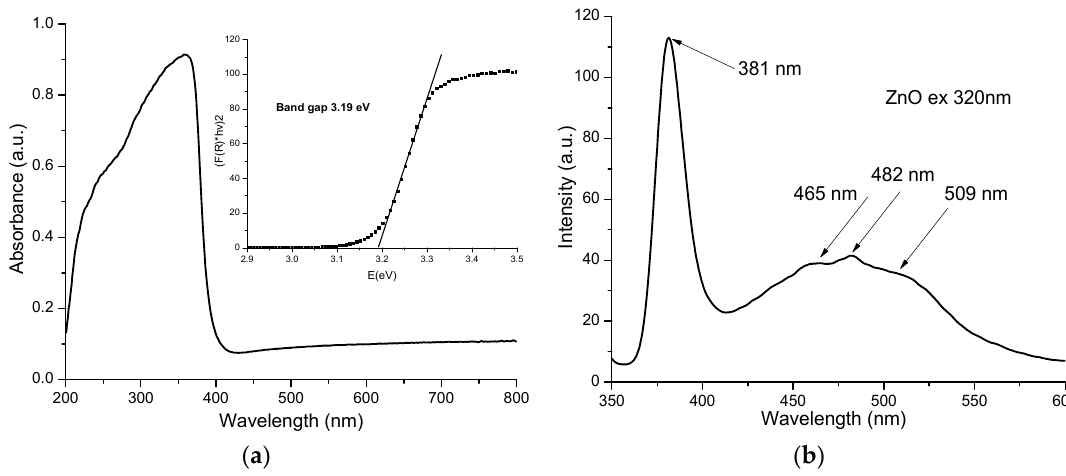
Figure 4. UV-Vis spectrum of ZnO; ( a ) with band-gap determination (inset); fluorescence spectrum of ZnO for excitation wavelength 320 nm ( b ).